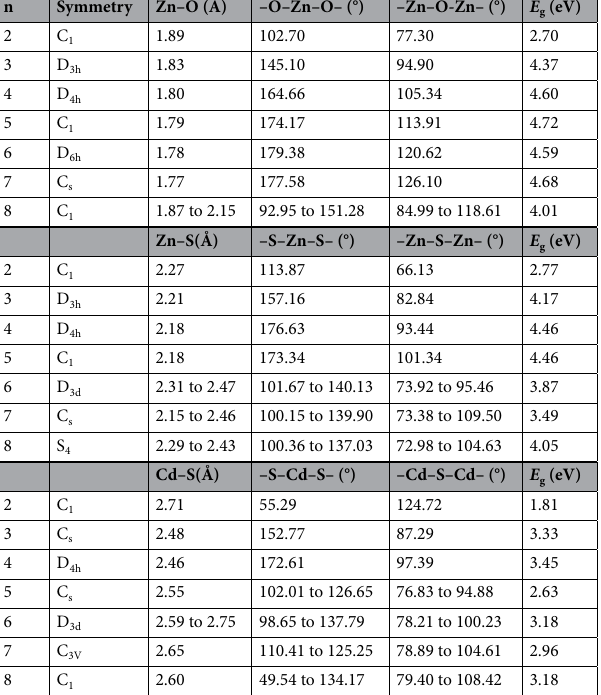
Table 3. The symmetry, bond length, bond angle, and energy gap between HOMO and LUMO ( E g ) of Zn n O n , Zn n S n , and Cd n S n , n = 2–8 at their lowest energy